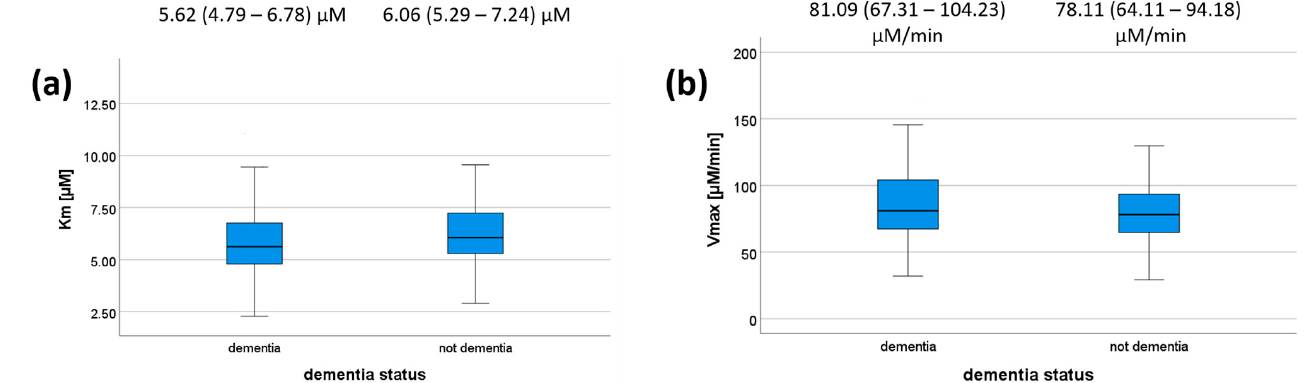
Figure 1. MMSE scores for each genotype. The box plots display the 5-, 25-, 50-, 75-, and 95-percentage intervals for the genotypes ( a ) rs662, ( b ) rs854560, ( c ) rs705379, and ( d ) rs705381. The medians (interquartile ranges) are displayed above each box plot. MMSE: mini mental state examination. For ( a ), N (AA) = 75, N (GA) = 51, N (GG) = 11. For ( b ), N (TT) = 18, N (TA) = 61, N (AA) = 58. For ( c ), N (AA) = 37, N (GA) = 55, N (GG) = 45. For ( d ), N (TT) = 14, N (TC) = 42, N (CC) = 81.